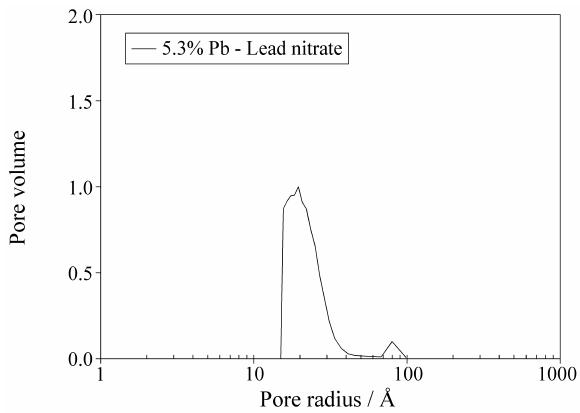
Figure 8. Pore size distribution of gel obtained via lead nitrate heat treated at 105 °C (the weight of the sample was not considered, then volume scale is relative). Figure 10.